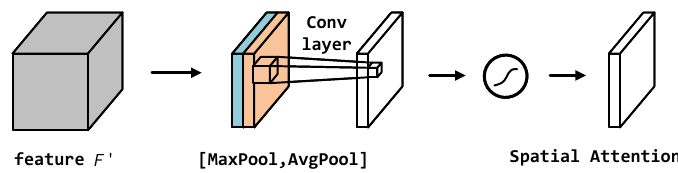
Figure 3. SAM attention mechanism